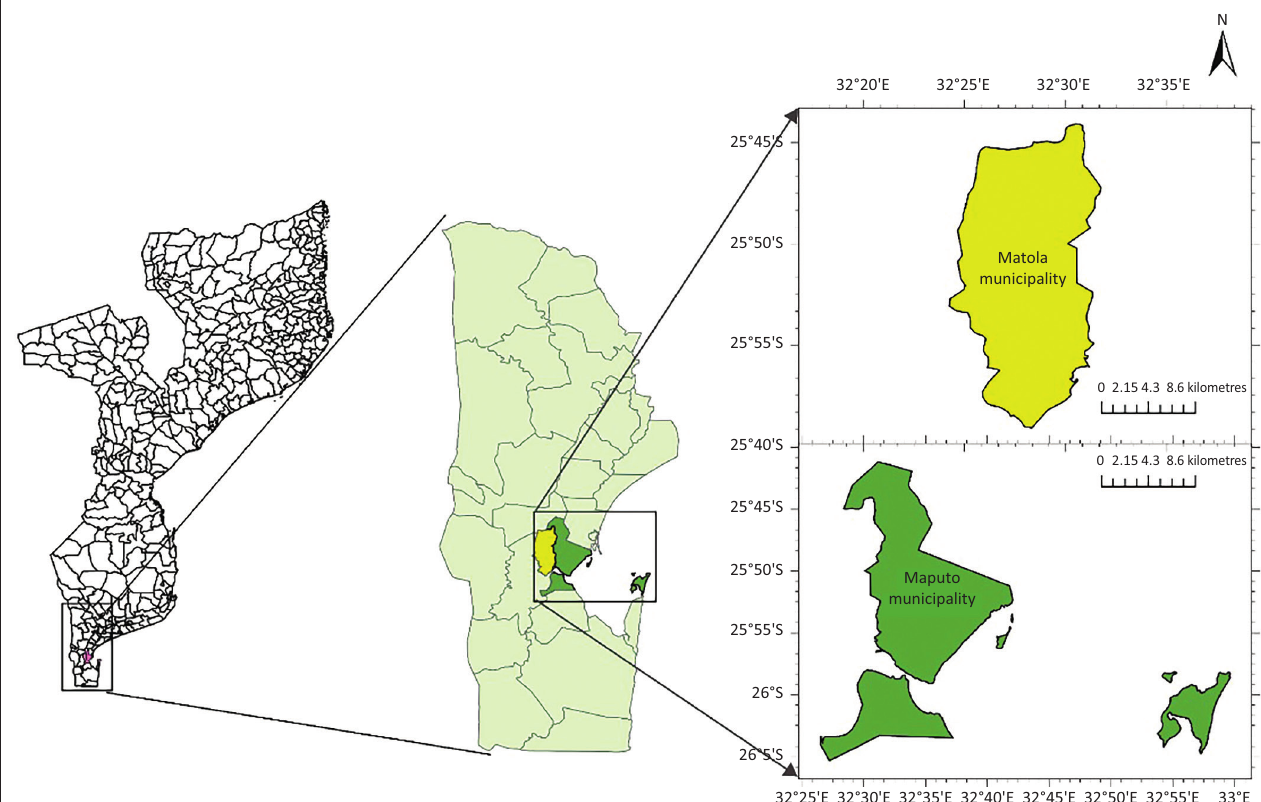
FIGURE 1: Study area, showing (a) Mozambique administrative division, (b) Maputo province and (c) Maputo and Matola